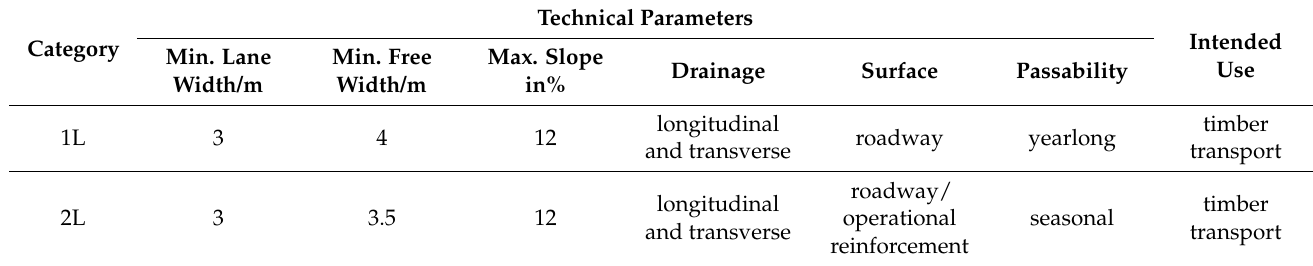
Table 1. Forest road category according to CSN 73